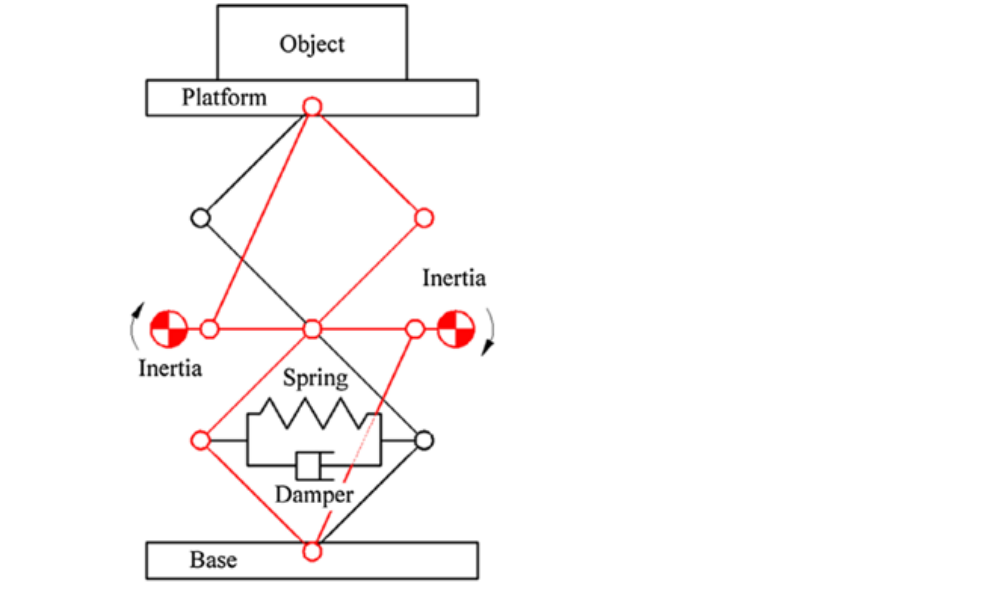
Figure 16. Bionic vibration isolation device based on human structure [69].